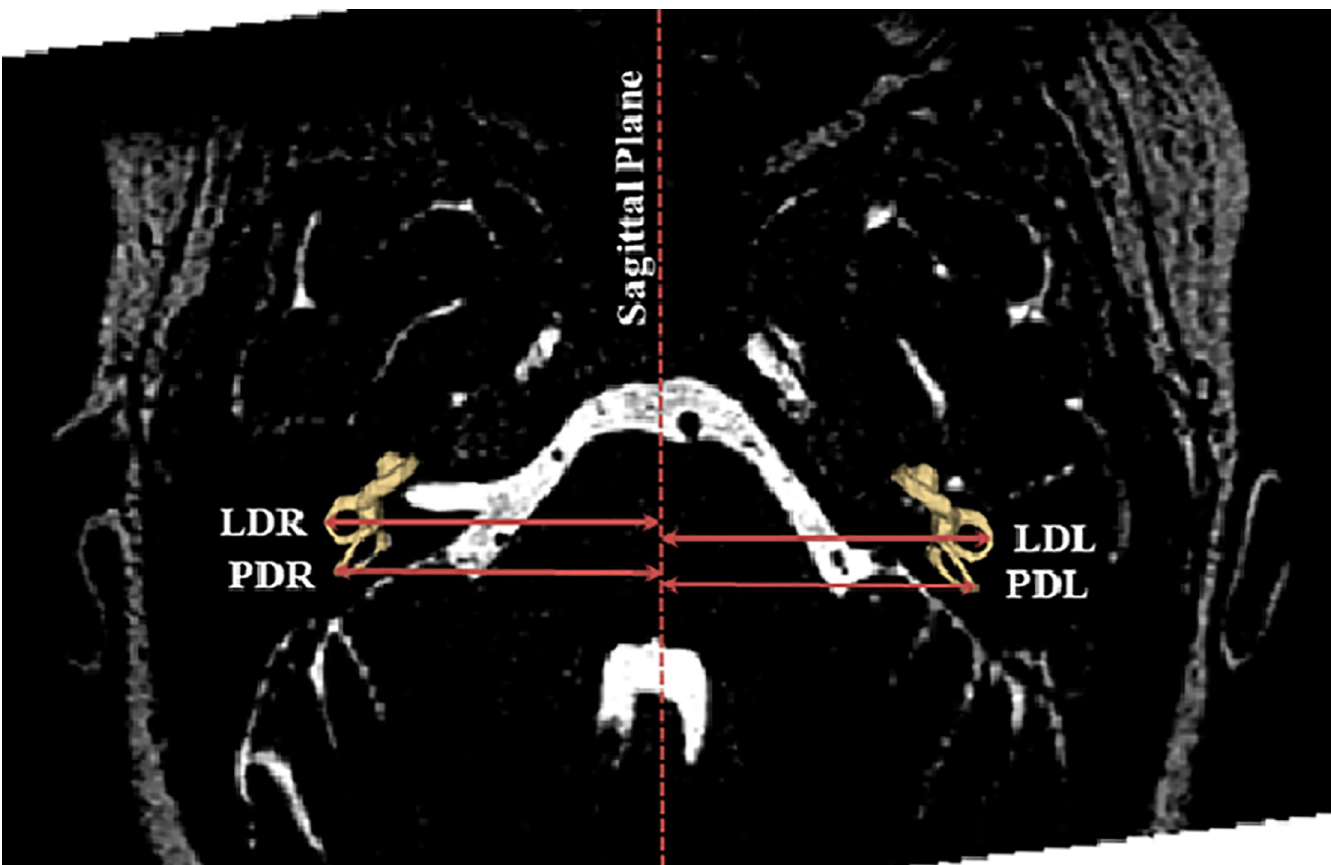
Fig 1. SCC distance measurements. Measurements of the horizontal distance from the lateral and posterior canals to the sagittal plane midline. LDR = lateral canal distance on the right, LDL = lateral canal distance on the left, PDR = posterior canal distance on the right, PDL = posterior canal distance left.